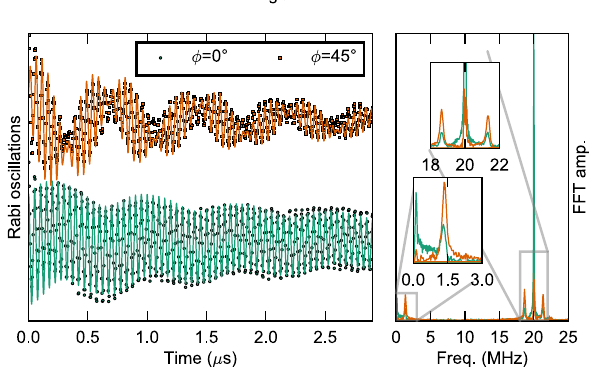
0 ◦ = H RF are ⊥ ). The solid lines are